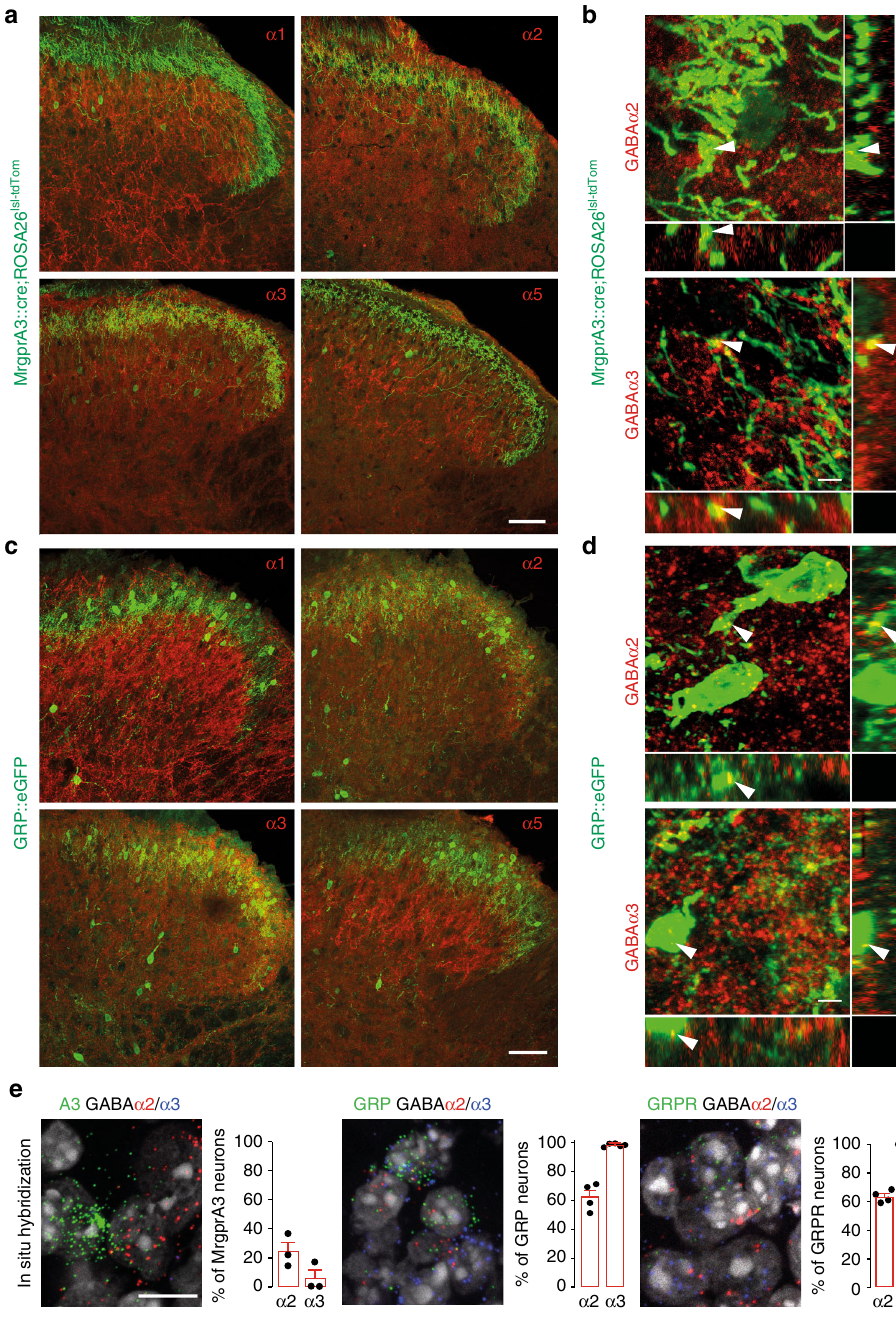
Fig. 2 α 2 and α 3GABA A Rs are expressed on key elements of a spinal itch relay circuit. Expression of GABA A R α subunits in MrgprA3 positive primary pruritoceptors ( a , b ) and GRP positive dorsal horn neurons ( c , d ). a – d show transverse sections of the lumbar spinal cord of two MrgprA3::cre;ROSA26 lsl- tdTom and three GRP::eGFP transgenic mice stained with antibodies against α 1, α 2, α 3, and α 5GABA A R subunits. td-Tom and eGFP are shown in green, GABA A R α subunits in red. Overlapping expression (light green/yellow) of GABA A R α subunits with tdTom and eGFP was seen for α 2 and α 3GABA A R subunits, but not for α 1 and α 5GABA A R subunits. b , d Confocal analyses. Orthogonal views (stacks of 17 – 35 sections (1024 × 1024 pixels) at 0.4 µ m intervals) verify co-localization of α 2 and α 3GABA A R subunits with MrgprA3 positive fi bers and terminals ( b ) and GRP positive dorsal horn neurons ( e ) at higher magni fi cation. Arrowheads indicate examples of co-localization. Scales bars, 50 µ m ( a , c ), 5 µ m ( b , d ). e Fluorescent in situ hybridization signals of α 2 (red) and α 3 (blue) subunits together with eGFP (to detect MrgprA3 neurons DRG neurons in MrgprA3::cre-eGFP transgenic mice), GRP and GRPR in situ hybridization signals (green, in wild-type mice). DAPI staining (gray) was used to indicate the location of cells. Bar charts: percent GABA A R α subunit positive neurons among the marker (MrgprA3, GRP, and GRPR) positive neurons. Each data point represents one mouse. Sections were obtained from 3 – 5 mice. Scale bar, 20 µ